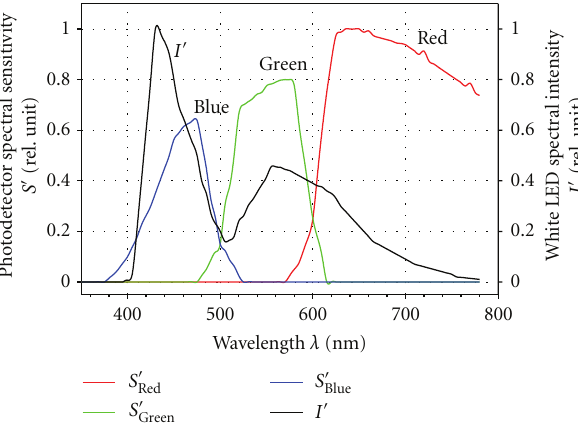
Figure 3: Photodetector spectral sensitivity and white LED spectral